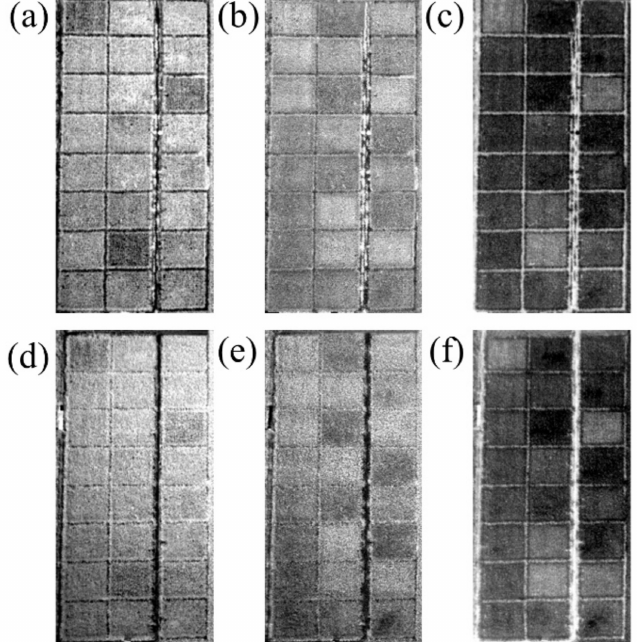
Figure 5. TCT-component images: ( a ) brightness at booting stage; ( b ) greenness at booting stage; ( c ) third component at booting stage; ( d ) brightness at heading stage; ( e ) greenness at heading stage; ( f ) third component at heading